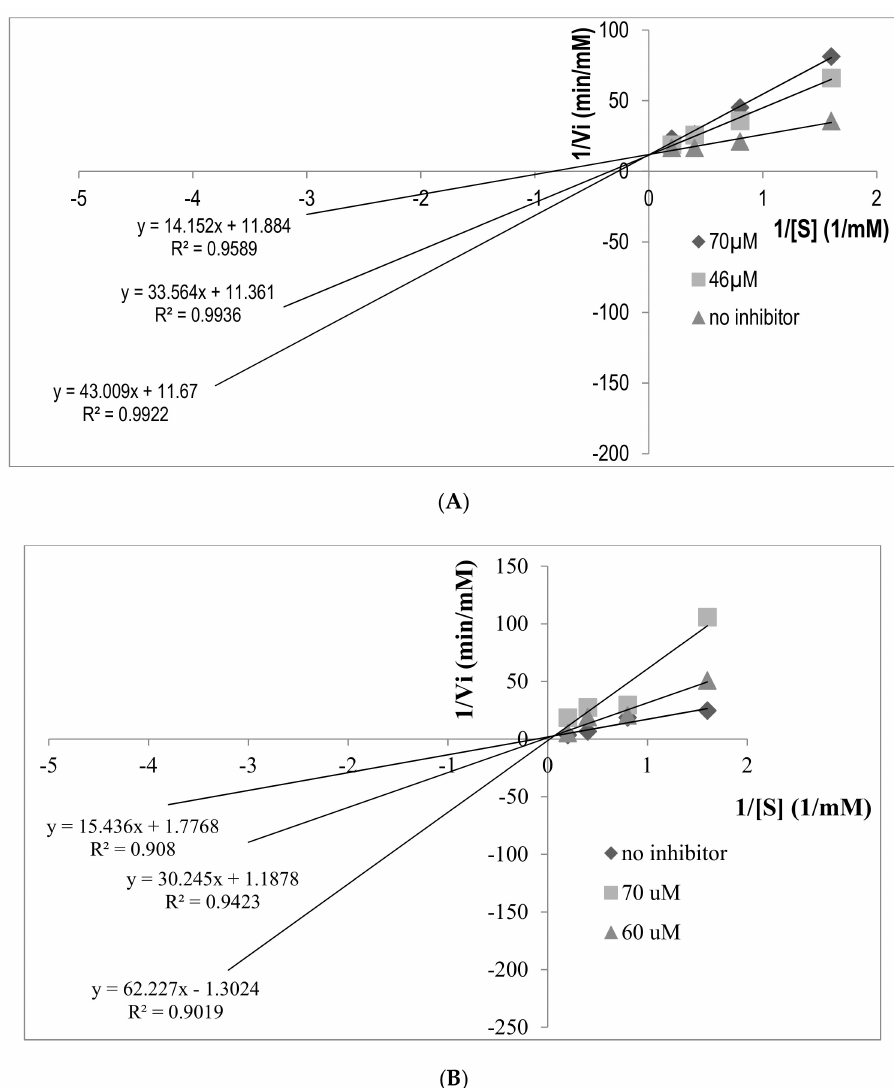
Figure 5. The inhibition kinetics of FP-5 and AA-7. ( A ) The Lineweaver–Burk plot of FP-5 against ACE; ( B ) The Lineweaver–Burk plot of AA-7 against